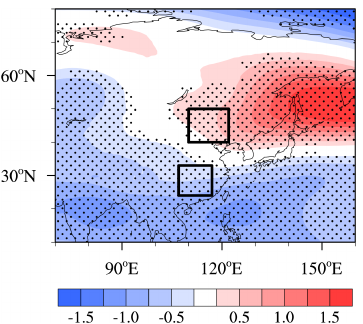
Figure 9. Composite differences of geopotential height at 500hPa in JJA between three high- and low-SIOD years based on the en- semble of 40 CESM-LE simulations during 1980–2019. The black dots indicate that the mathematical sign of the composite results of more than 60% of the members is consistent with the ensemble mean. The black boxes represent the centers of AC NC and C PRD , respectively.